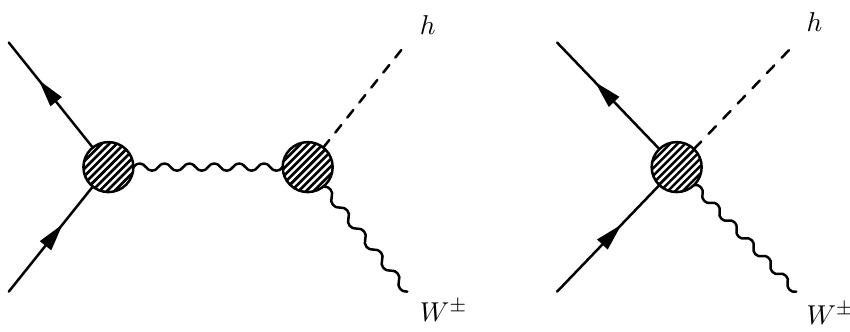
Figure 1 . Diagrams contributing to pp ! h W (cid:6) . The shaded circles represent integrated-out new physics, and mark the vertices modi(cid:12)ed by the HDOs we have included in our analysis. Left : associated production via an s -channel W boson. In this case the purely bosonic operators modify the hWW coupling, and the contact operators modify the quark- W vertex. Right : the four-point contact interaction that can also mediate pp ! h W (cid:6)